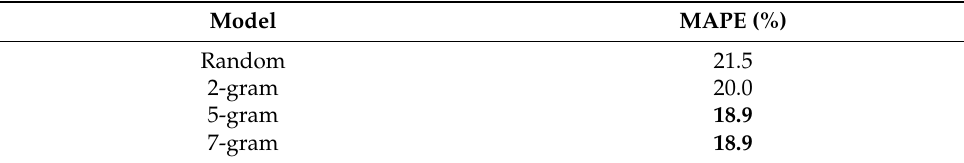
Table 4. N-gram and overall detection performance (closed food and hybrid CTC/attention model): Five-class detection (left chewing, right chewing, front biting, swallowing, and others).